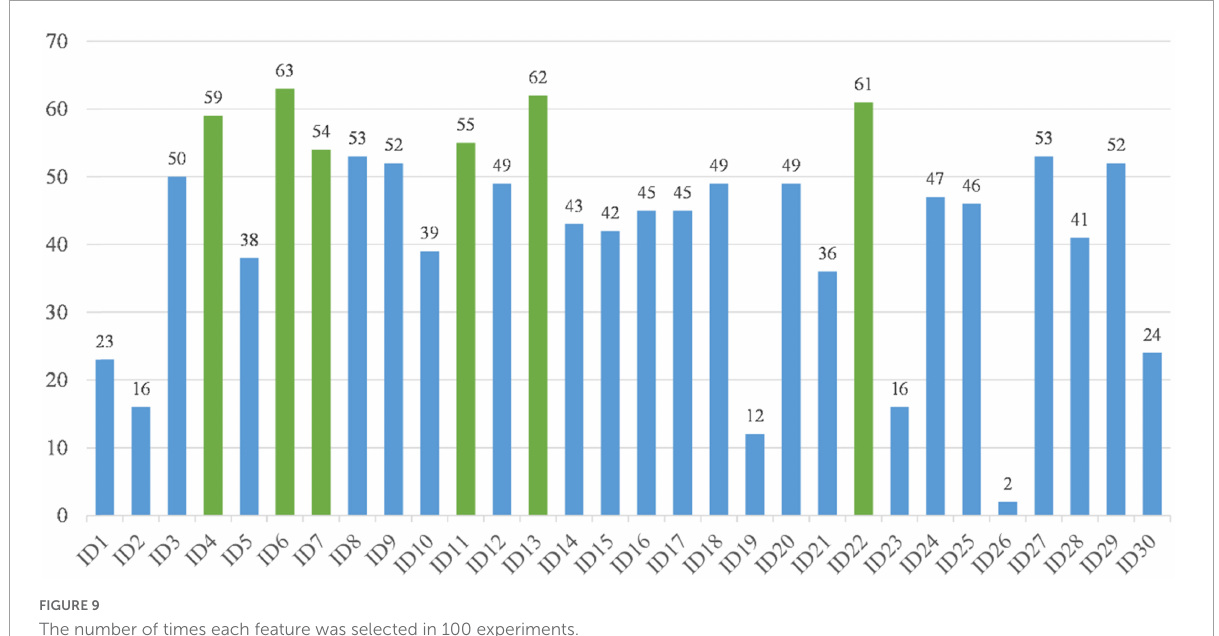
FIGURE9 The number of times each feature was selected in 100